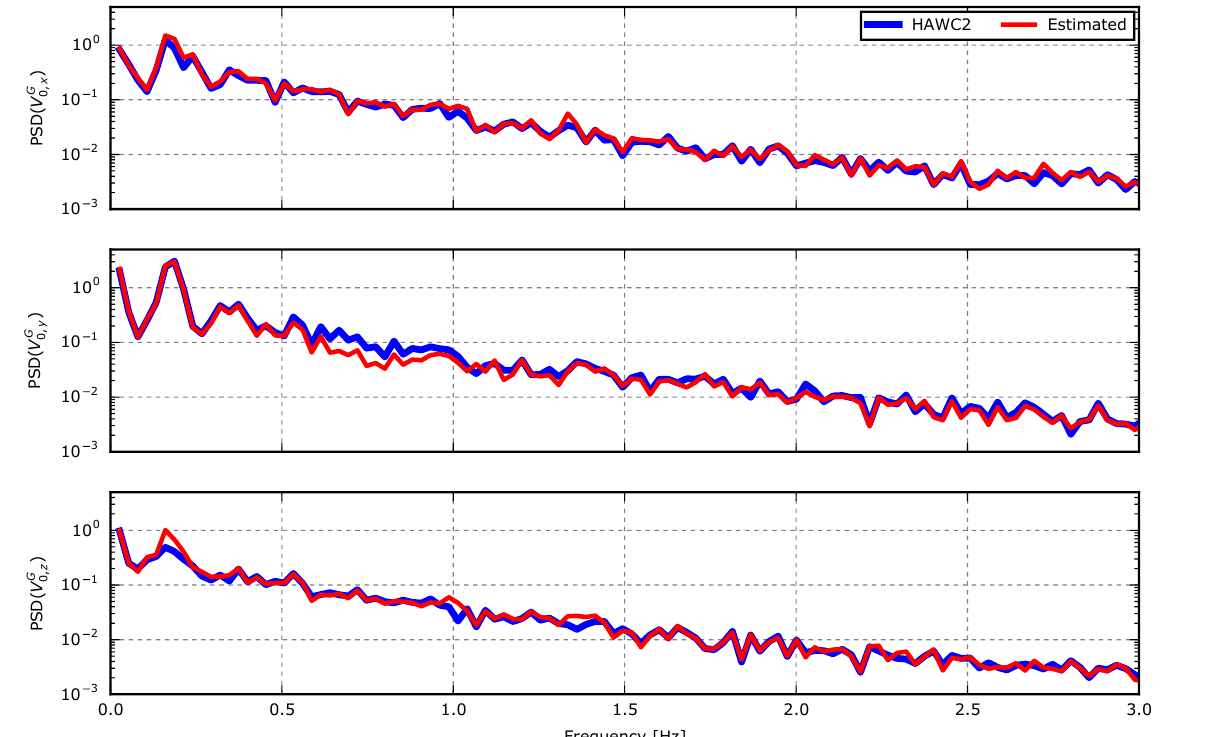
Figure 16. HAWC2 results including the power spectrum density of the free wind speed estimated in turbulent inflow for a flexible structural model.